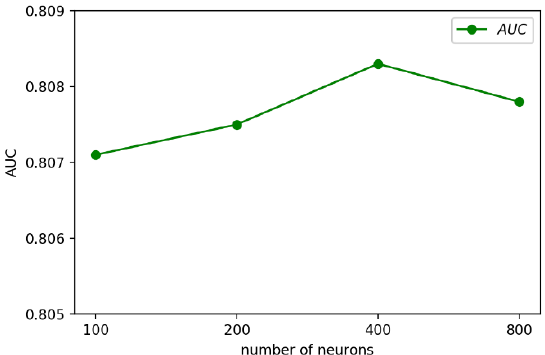
Figure 6. The impact of the number of neurons on the model.